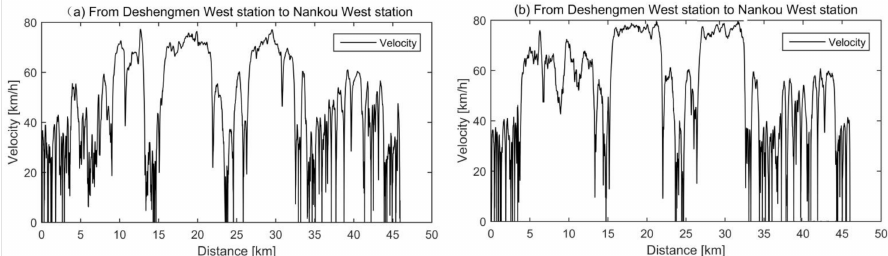
Figure 2. Driving cycles of two contiguous buses in Beijing.